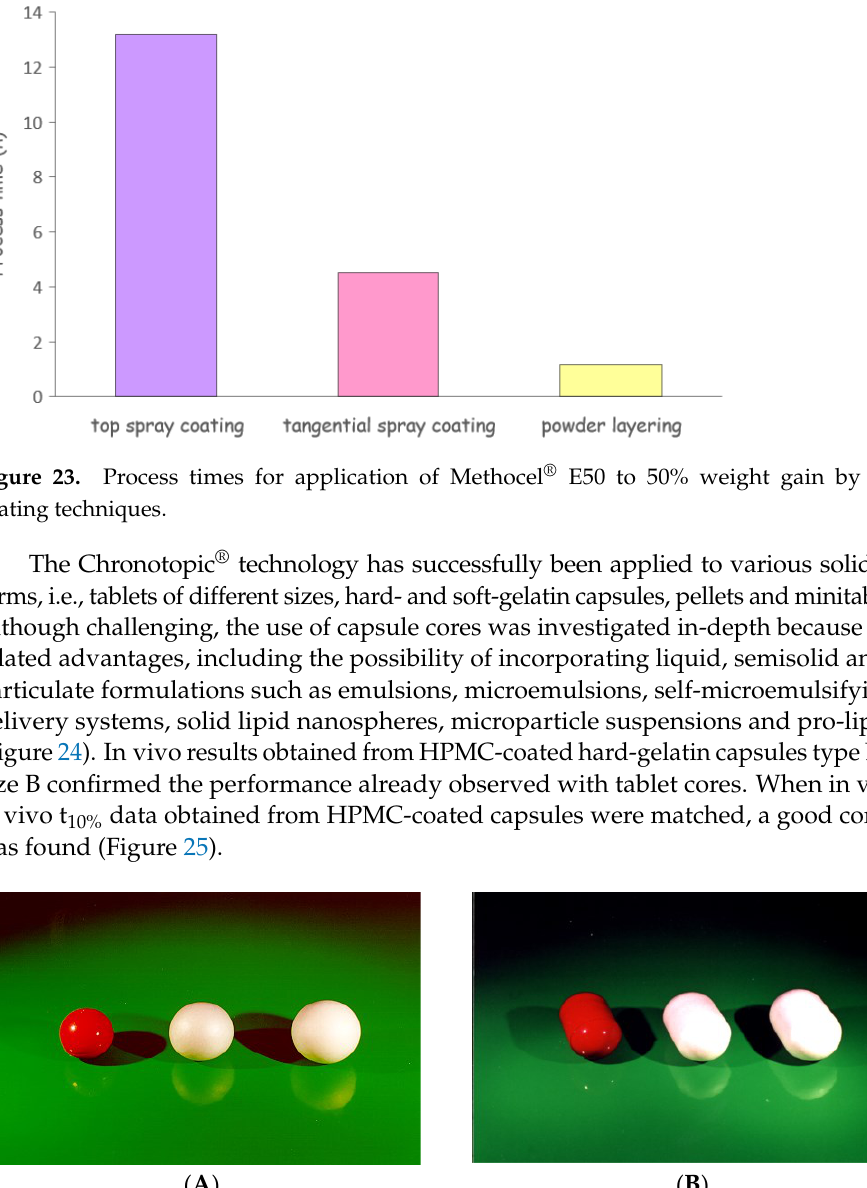
Figure 22. In vitro lag times in media having different pH ( A ) and ionic strength ( B ) of systems coated with Methocel ® E50 to 20% weight gain. Adapted with permission from Ref. [60]. 2004, Else- vier.